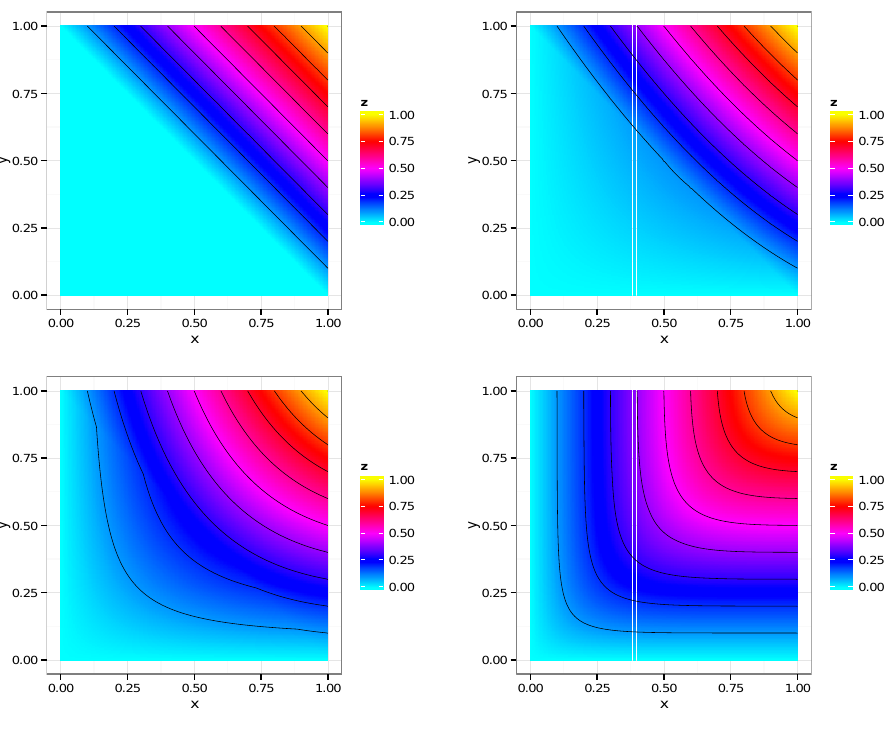
Figure 3: Image plot of S n